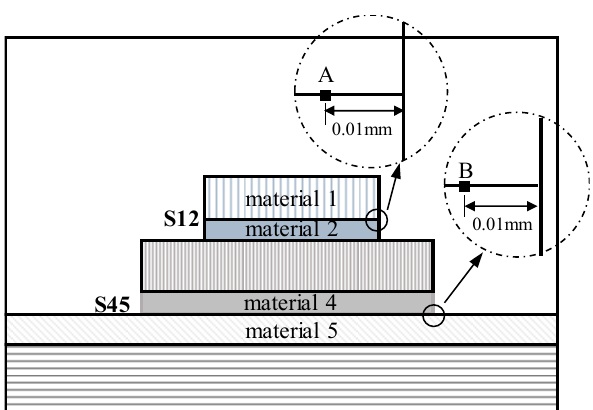
Figure 7. Specific points A and B at the interfacial edges.